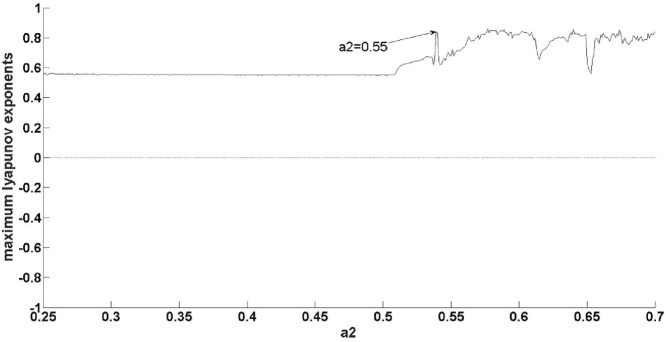
Maximum Lyapunov at situation 2.